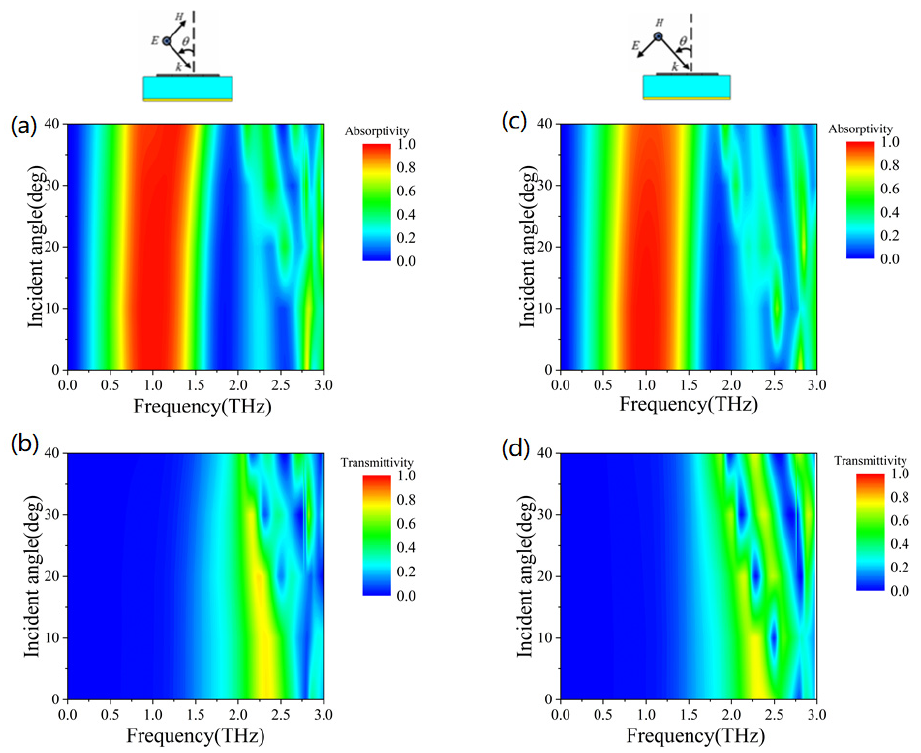
Figure 5. ( a ) The simulation results of absorption rate variation with different incident angles in TE mode; ( b ) Transmittance changes with different incident angles in TE mode; ( c ) Absorption rates changing with different incident angles in TM mode; ( d ) Transmittance changing with different incident angles in TM mode.